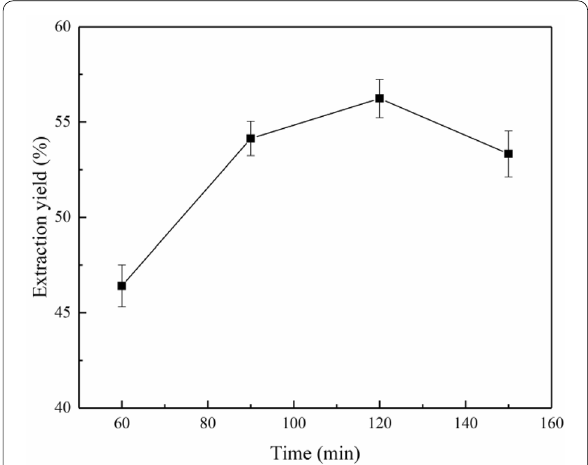
Fig. 2 Influence of the reaction time on the lignin extraction yield at the extraction temperature of 170 °C using 70% aqueous ethanol and a solid/liquid ratio of 1/15